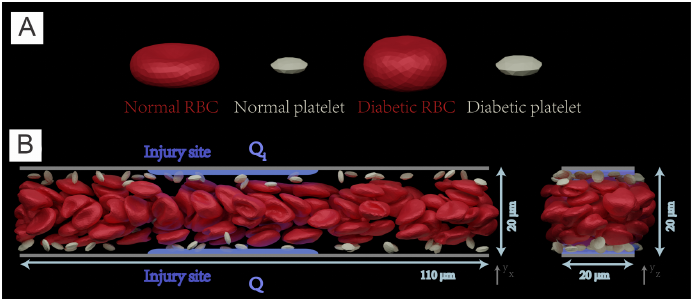
Figure 6. ( A ) Normal and diabetic RBC and platelet models, validated in Chang et al. [58], are employed to simulate blood flow in ( B ) a 3D rectangular microchannel of size of 110 µ m × 20 µ m × 20 µ m. Left: front view, right: side view. Solvent particles in the simulate carry 22 species for modeling the coagulation cascade that is initiated from two injury sites (highlighted with blue color lines) with a size of 40 µ m located at the upper and bottom channel wall respectively. Figure is reproduced from